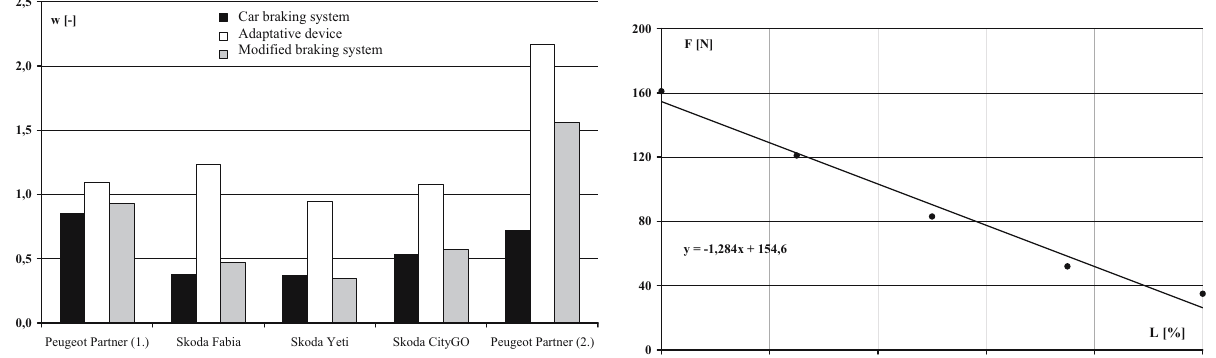
Figure 6: Comparison of the proportionality coe ffi cients between the braking e ffi ciency index and the force applied to the pedal and brake lever for each car.